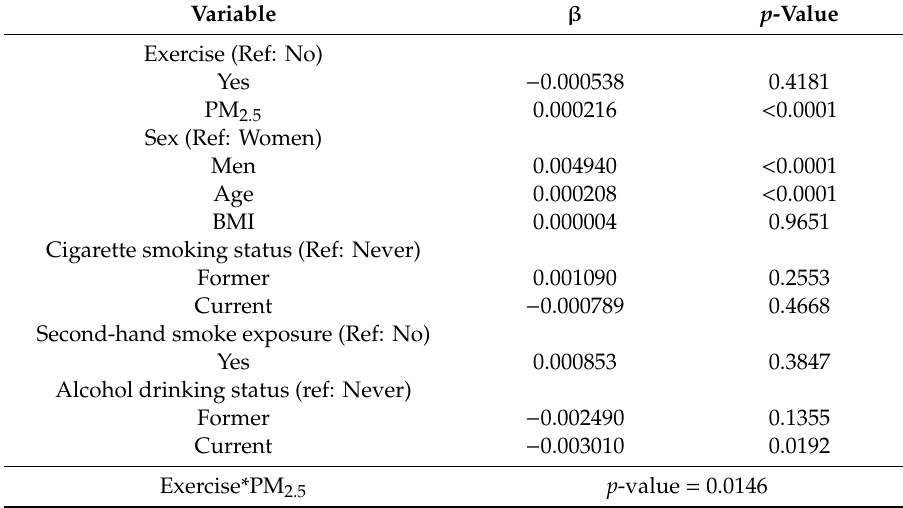
Table 2. Association of exercise and PM 2.5 with SOX2-promoter methylation in